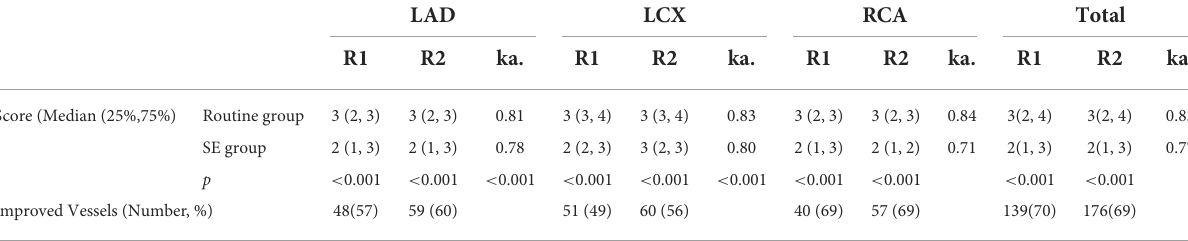
TABLE 4 Comparison of image quality scores between the routine and SE groups. LAD LCX RCA